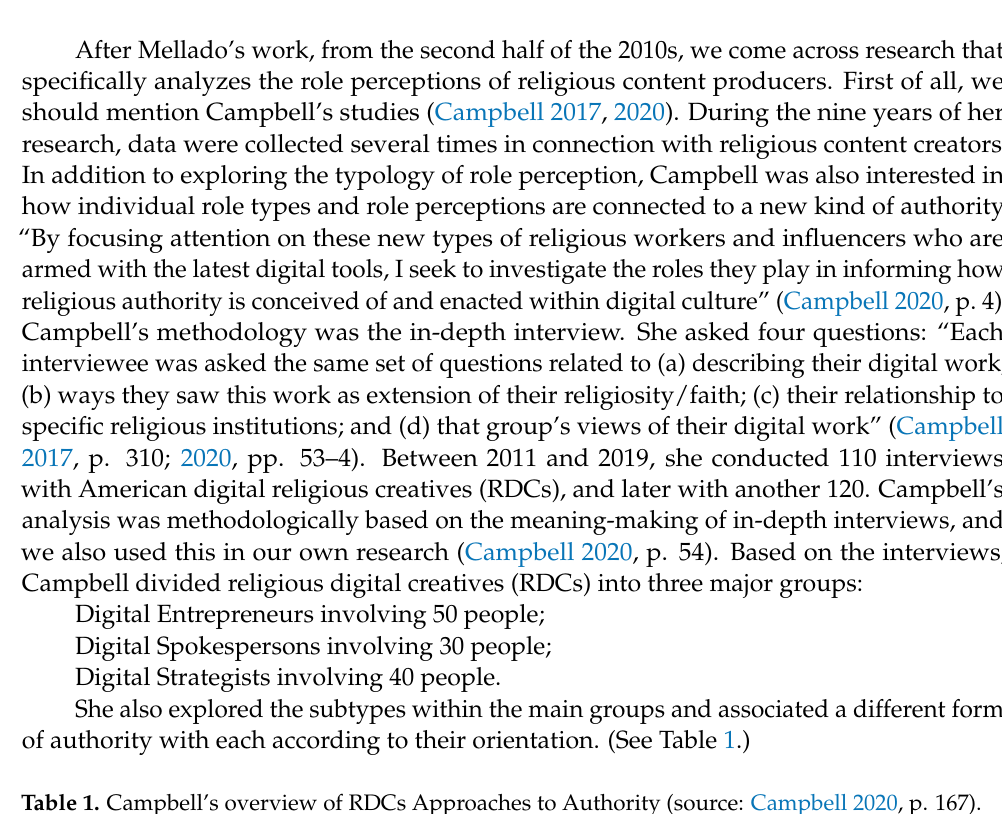
Table 1. Campbell’s overview of RDCs Approaches to Authority (source: Campbell 2020, p. 167).